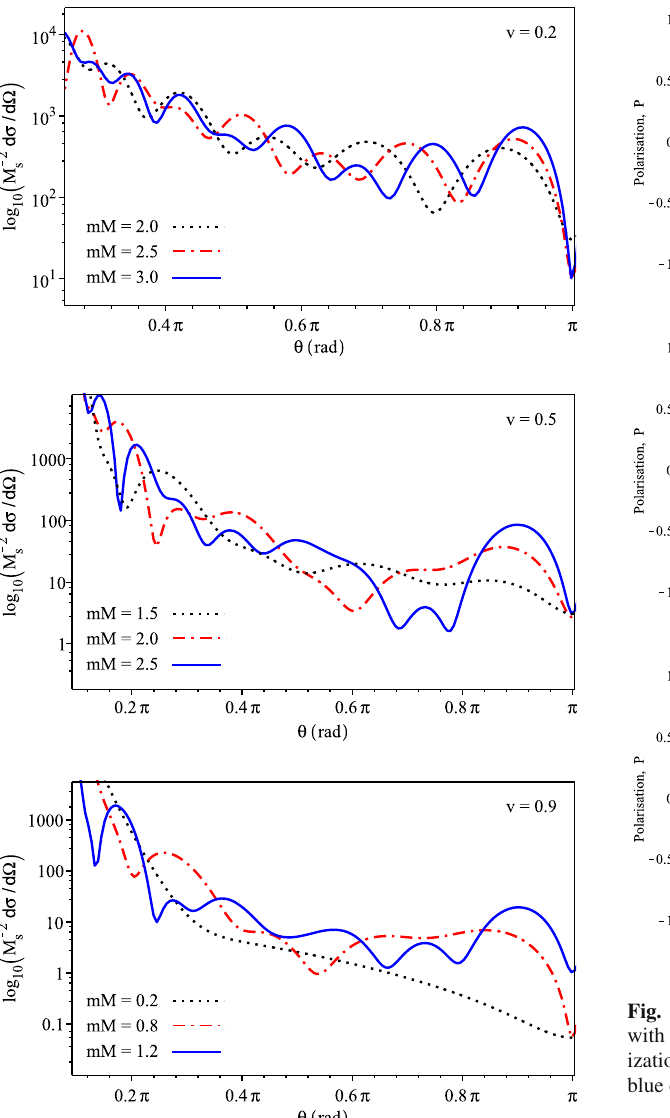
Fig. 2 Glory and spiral scattering by a massive spherical body over a range of gravitational couplings mM and a fixed value of fermion’s speed v . The glory magnitude and angular frequency of spiral scattering are enhanced with the body’s mass M